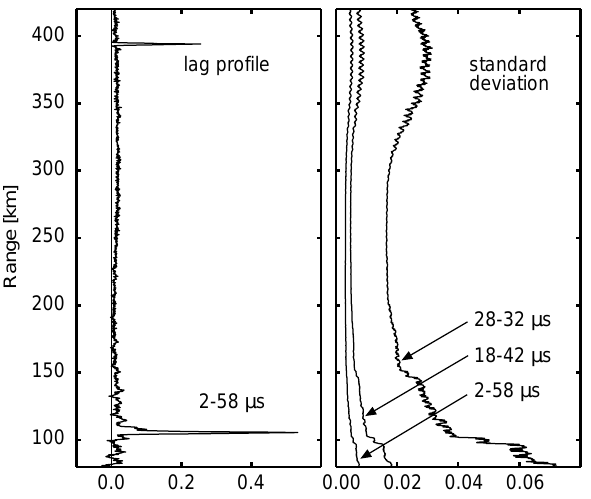
, ob- Fig. 7. Left: The range ambiguity function of the 30- µ s lag for j the modulation in Fig. 3 with standard decoding filter. Right: The weight function used in comparing the inversion method and stan- dard Barker decoding. The functions are otherwise similar but, in the right-hand panel, the sidelobes have been